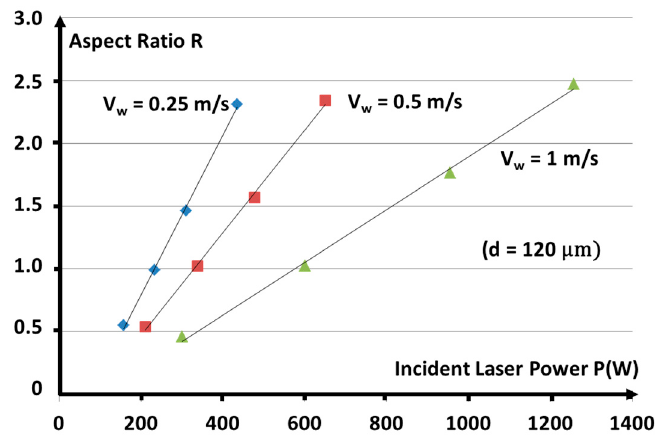
Figure 4. Examples of the aspect ratio R dependence with the incident power P for different welding speeds V w (a spot diameter d = 120 µm is used).